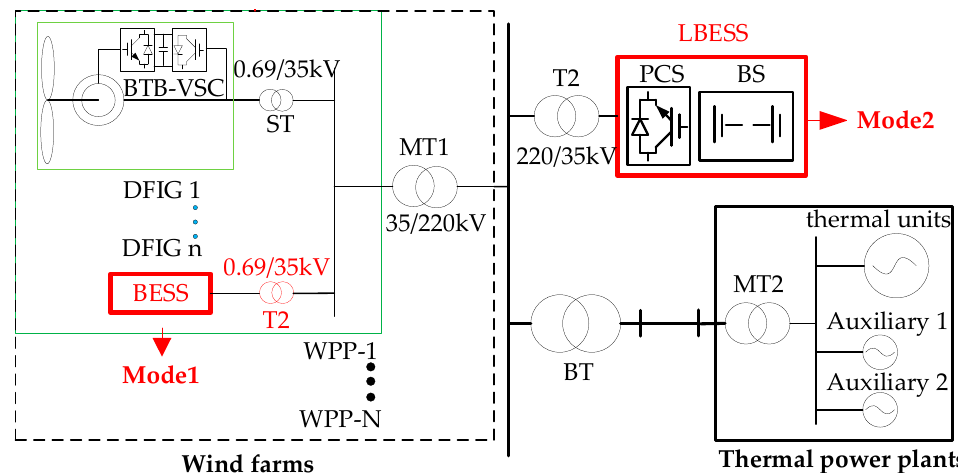
Figure 3. Energy storage configuration of WPP with ESS.